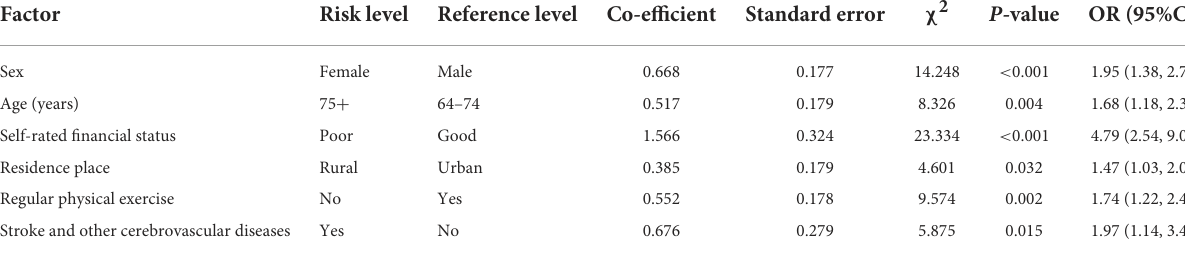
TABLE 2 Correlates of suspected dementia in older adults receiving primary